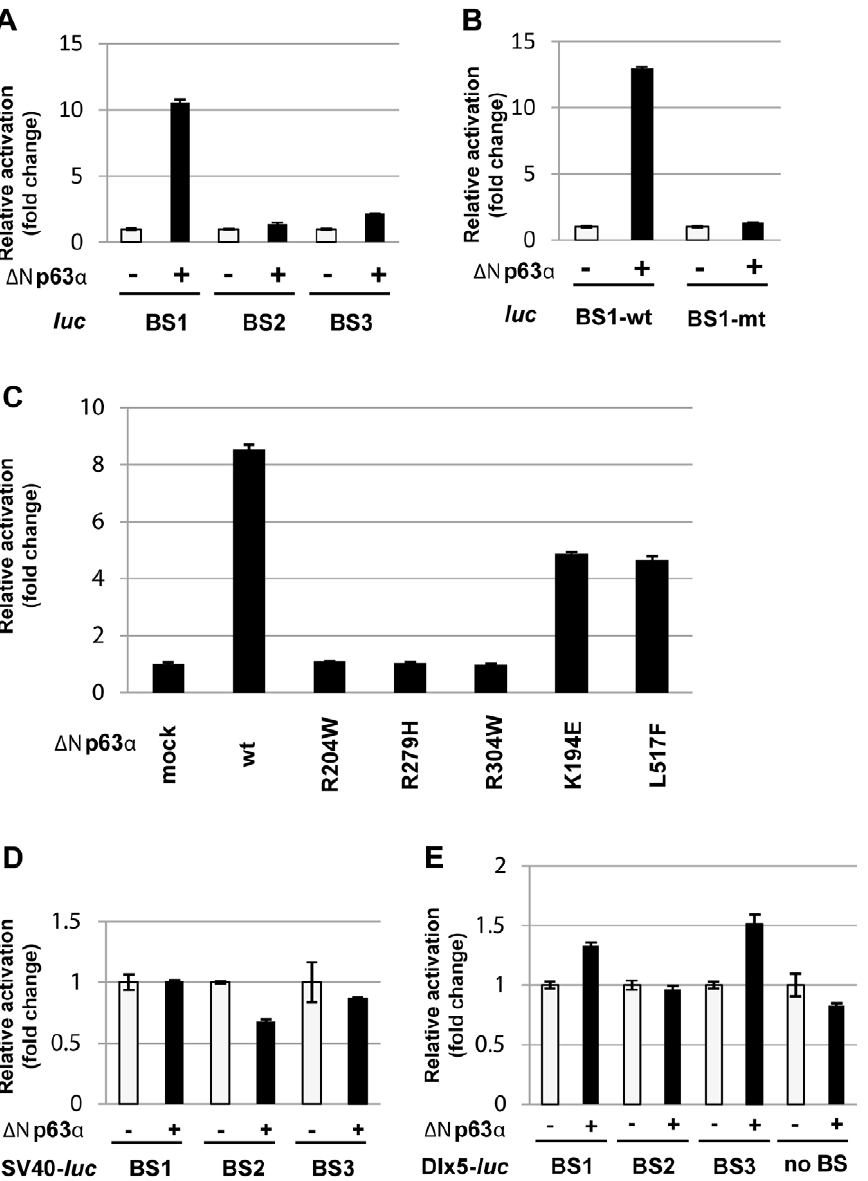
Figure 4. Transient transfection analysis of p63 binding sites at SHFM1 locus on chromosome 7. (A) The p63 binding sites SHFM1-BS1, - BS2 and -BS3 were tested in transient transfection assays in Saos2 cells. Transcription of the luciferase reporter was strongly activated by D Np63 a through SHFM1-BS1 binding site but only weakly activated through -BS2 and -BS3. (B) Activation was abolished when point mutations were introduced into the p63 binding motif in the SHFM1-BS1 binding site where the essential cytosine and guanine bases were mutated to adenosines. (C) Activation was impaired by p63 EEC mutations R204W, R279H and R304W and slightly reduced by SHFM1 mutation K194E and AEC mutation L517F. (D) No additional activation was observed when SHFM1-BS1, -BS2 and -BS3 were cloned in front of the SV40 promoter driving luciferase . (E) No activation was observed on the mouse Dlx5 promoter (no BS) and when SHFM1-BS1, -BS2 and -BS3 were cloned in front of the Dlx5 promoter.